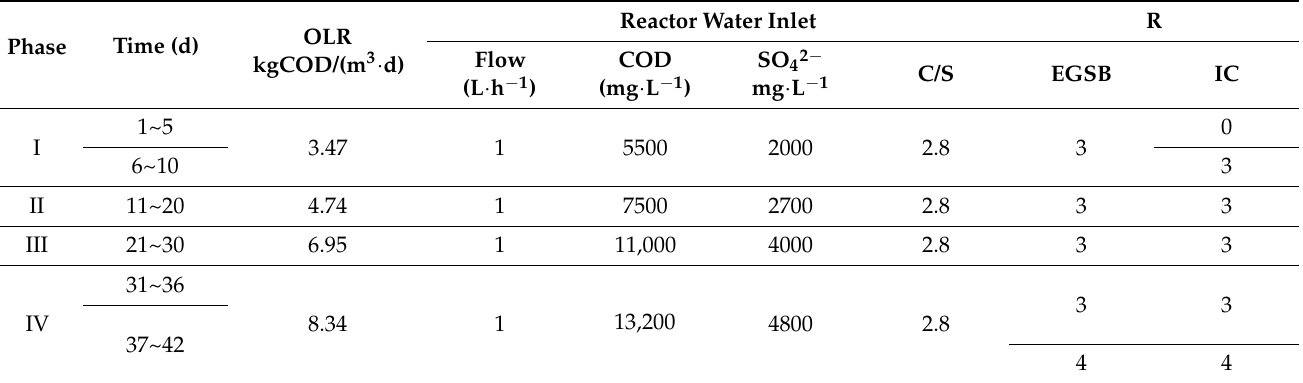
Table 3. Start-up procedure of reactors.